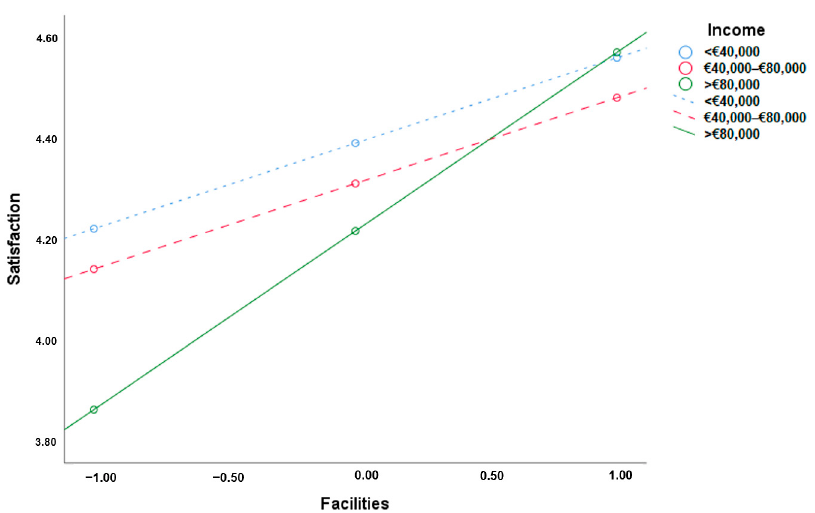
Figure 2. The moderating effect of income on the relationship between facilities and satisfaction.